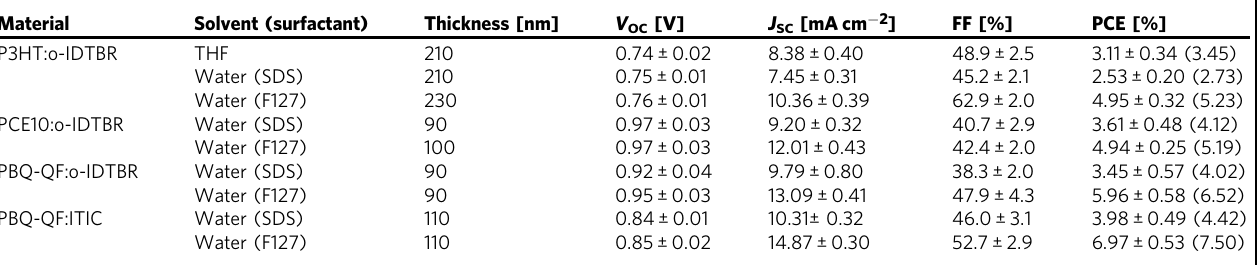
Table 1 Photovoltaic parameters of solar cells processed by solutions or NP dispersions Material Solvent